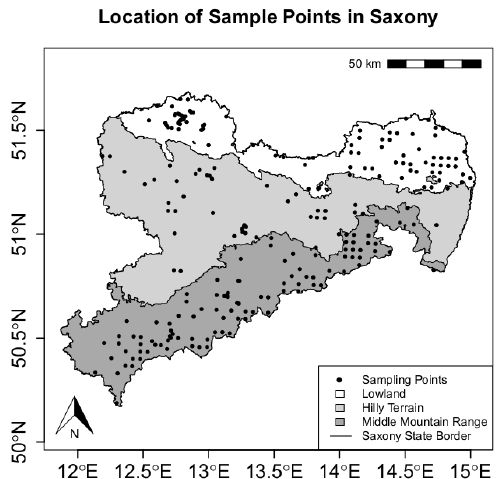
Figure 1. Location of sampling points in Saxony, Germany.